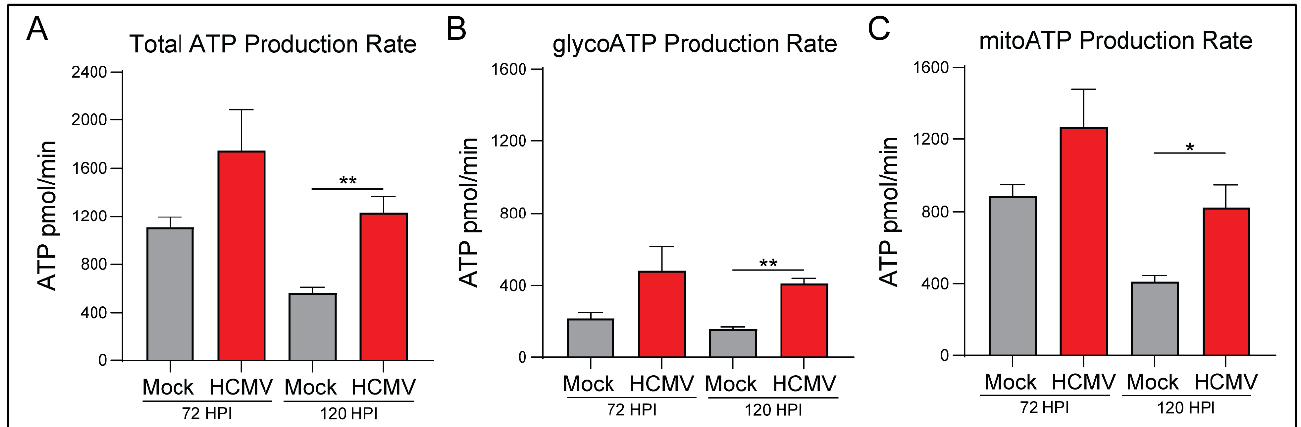
Figure 2. HCMV infection of LN-18 cells increases host ATP production using glycolysis and oxidative phosphorylation metabolic pathways. ( A ) Total ATP, ( B ) glycoATP, and ( C ) mitoATP production rates were quantified at 72 and 120 h post infection using the Seahorse XFe24 Real-Time ATP Rate kit. All samples were normalized to cell number. Graphs represent pooled data from three independent experiments. Mean ± the SEM of at least 3 triplicates. *, p < 0.05; **, p < 0.01.